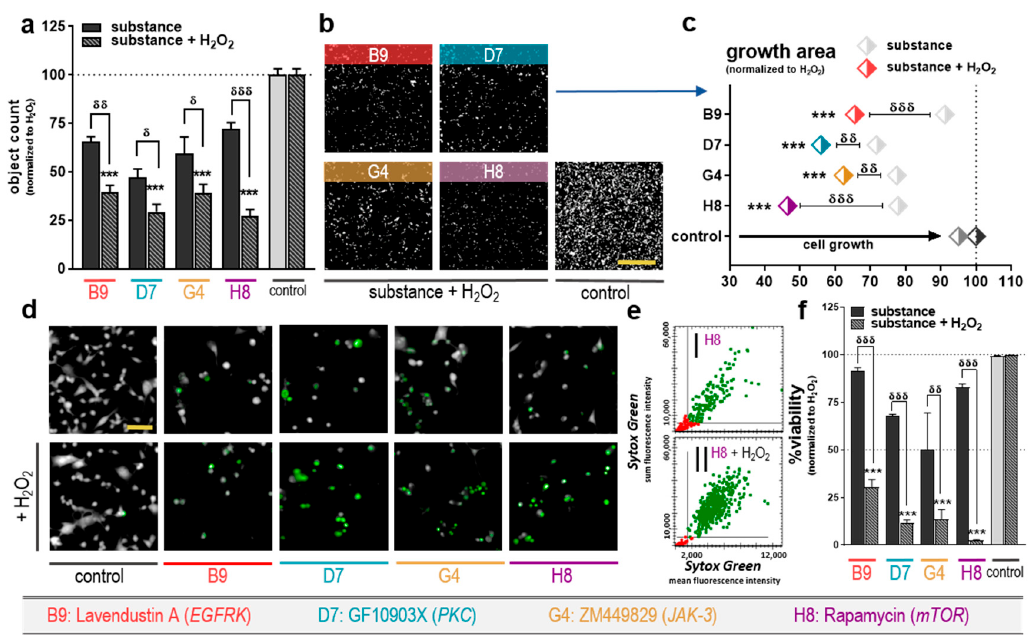
Figure 2. Combination of selected kinase inhibitors with H 2 O 2 reduced cell growth and were cytotoxic in colorectal cancer cells. ( a ) Cell count +SEM from high content image analysis of cancer cells that received selected inhibitors (+/- H 2 O 2 ) at 24 h. ( b ) Representative images of the cells’ cytosolic signal intensity (digital phase contrast) from nine fields of view (scale bar = 900 µm); ( c ) quantification of growth area; ( d ) representative images of the cells cytosolic signal and their Sytox Green fluorescence (scale bar = 150 µm) 24 h post-incubation with the selected substances (+/- H 2 O 2 ); ( e ) representative selection strategy to determine Sytox Green + (terminally dead) cells with imaging after treatment with substance H8 (+/- H 2 O 2 ); ( f ) quantification of cell viability +SEM 24 h post-incubation with the substances. Significance levels for the comparison of substances without H 2 O 2 to the respective substances with H 2 O 2 ( δ ), and of their combination (with H 2 O 2 ) to the H 2 O 2 -alone control (*) were determined via ANOVA. Data are representatives out of two independent replicates.